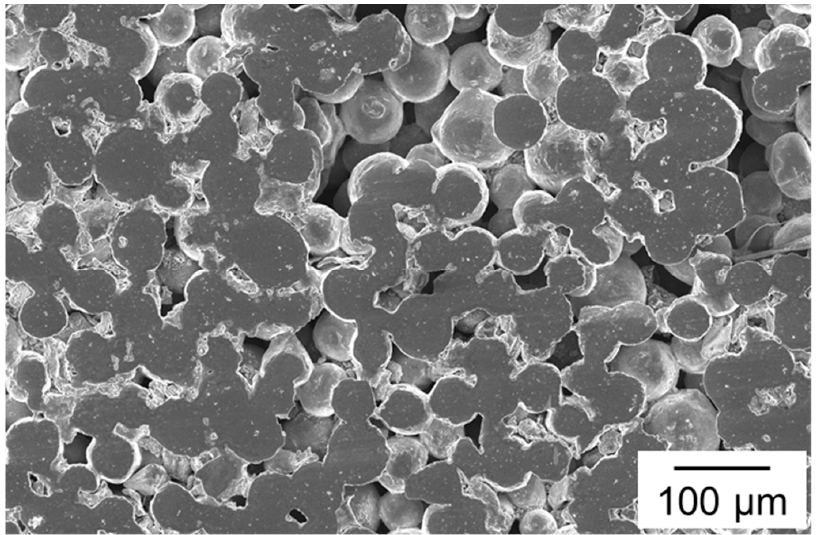
Figure 4. SEM micrograph of the powder part after heat treatment. A three-dimensional network is constructed through the necks between the powder particles.